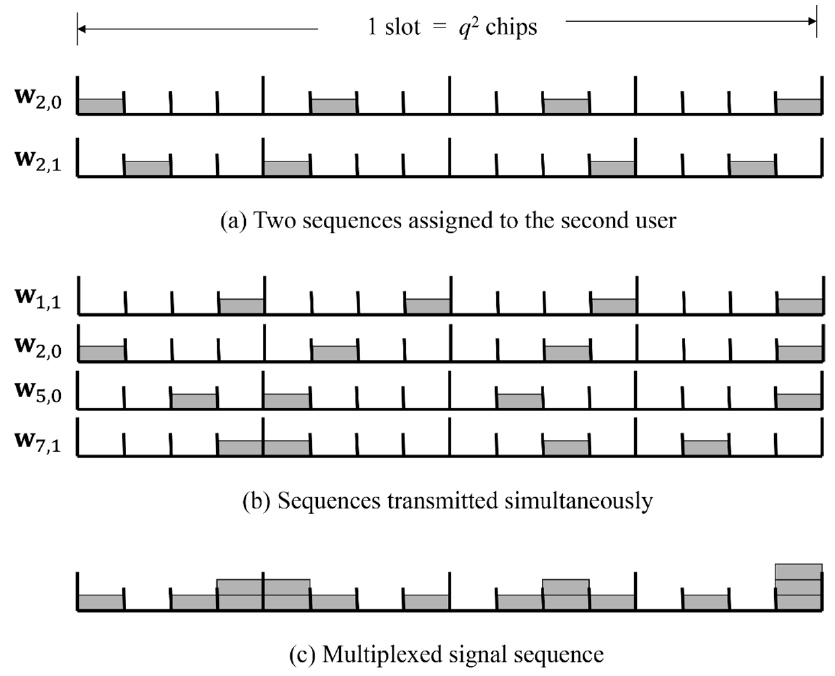
Figure 3. Examples of signal sequences for the EWO scheme.